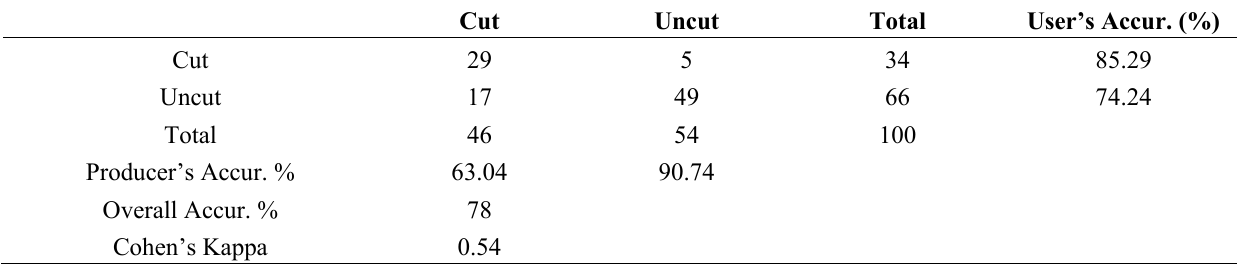
Table 6. Confusion matrix and accuracies of EVI seasonal statistics data set (1 June to 4 August).